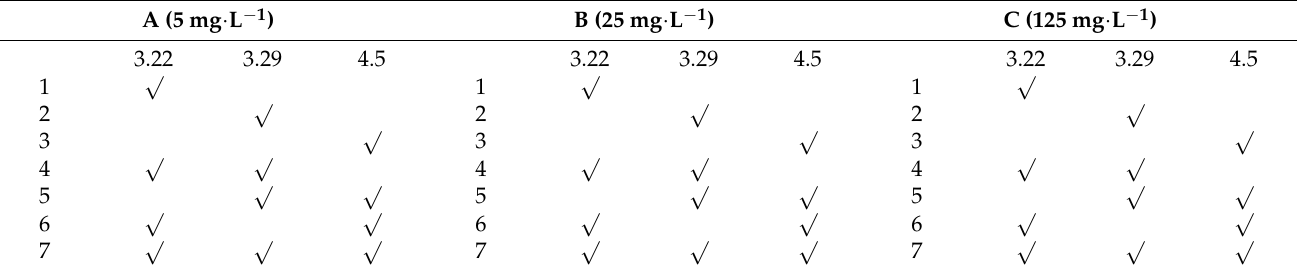
Table 5. Different treatment